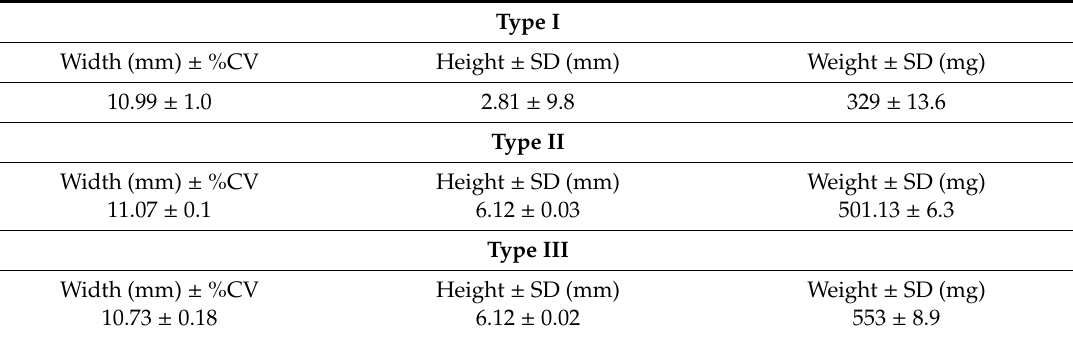
Table 2. Dimension and weight data for the